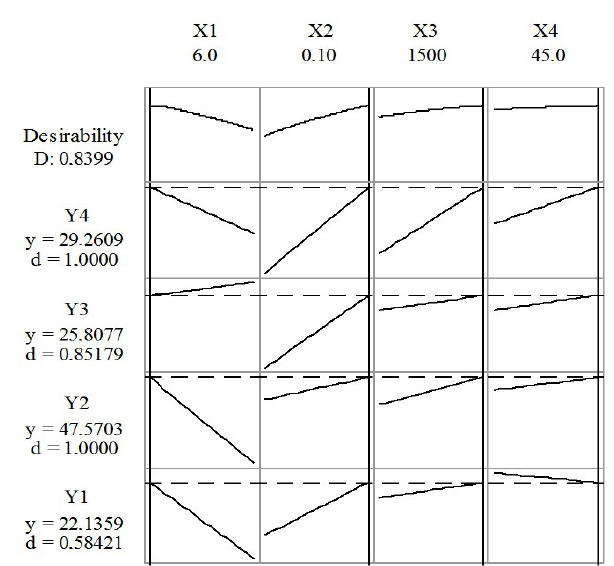
FIGURE 5 - Optimization plot of PGZ (Y1), Keto-P (Y2), OH-P (Y3), and RSG (Y4) as function of pH (X1, 6 to 10), HCl concentration (X2, 10.0 to 100.0 mmol/L), agitation speed (X3, 1000 to 1500 rpm), and extraction time (X4, 15 to 45 min).